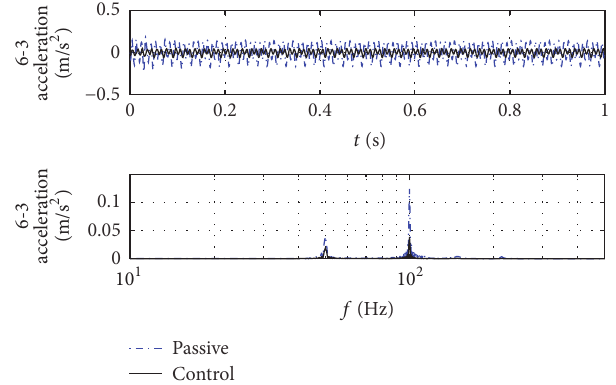
Figure 14: Comparison time-frequency domain curves of accelera- tion response of position 6-3 on the isolation system before and after being controlled under double sinusoidal interference.